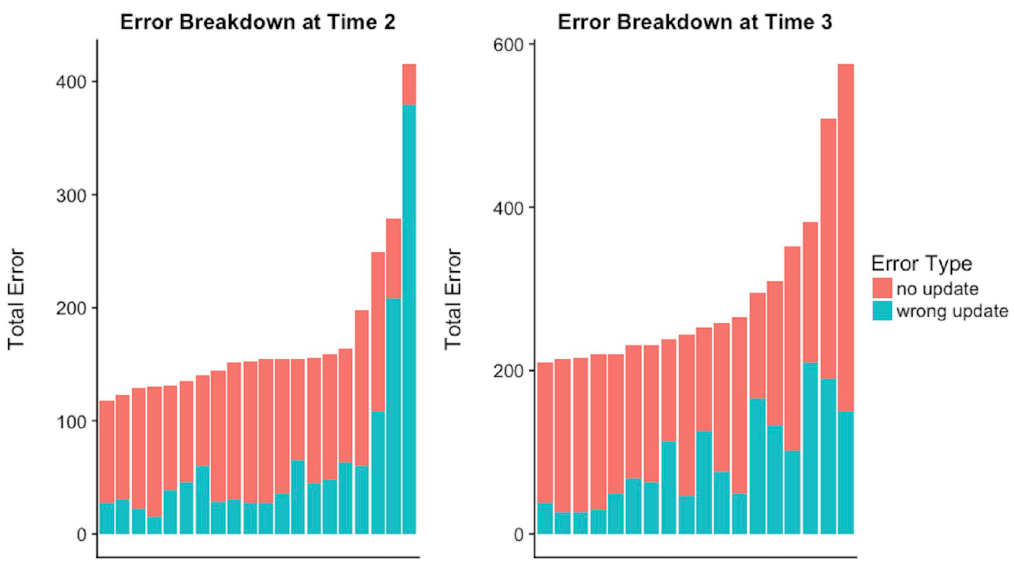
Fig 6. Error breakdown at Time 2 and Time 3 for all